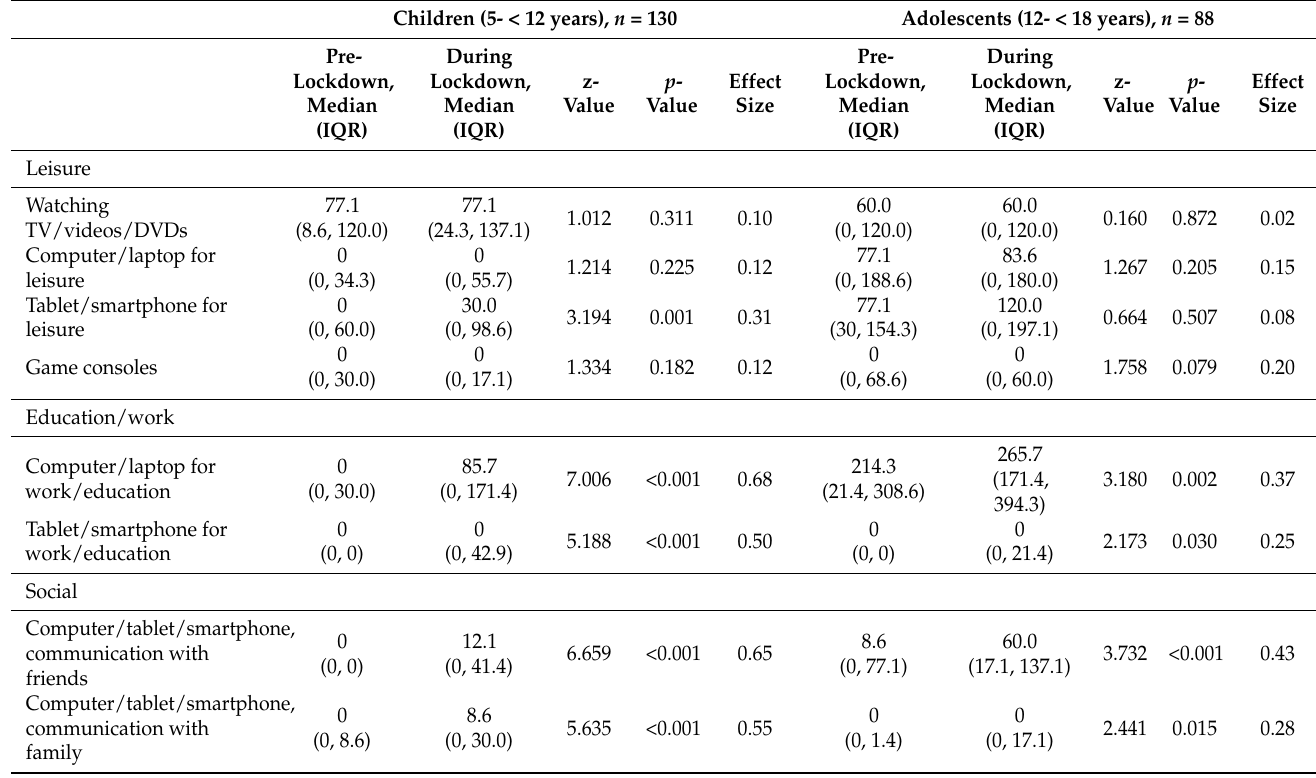
Table 3. Duration (median minutes per day, IQR) that children (5- < 12 years) and adolescents (12- < 18 years) engaged in screen time behaviours pre-lockdown (February 2020) and during (April/May 2020) lockdown